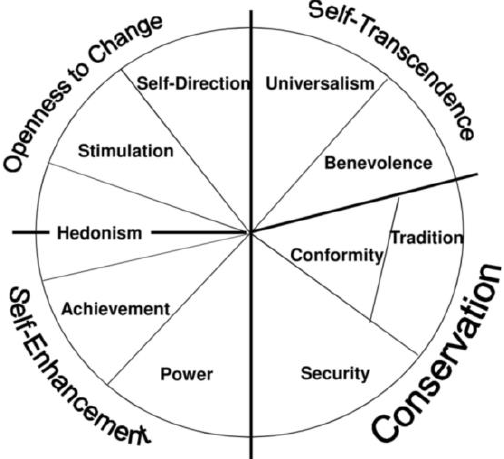
Figure 1. Theoretical model of relations among ten motivational types of values.